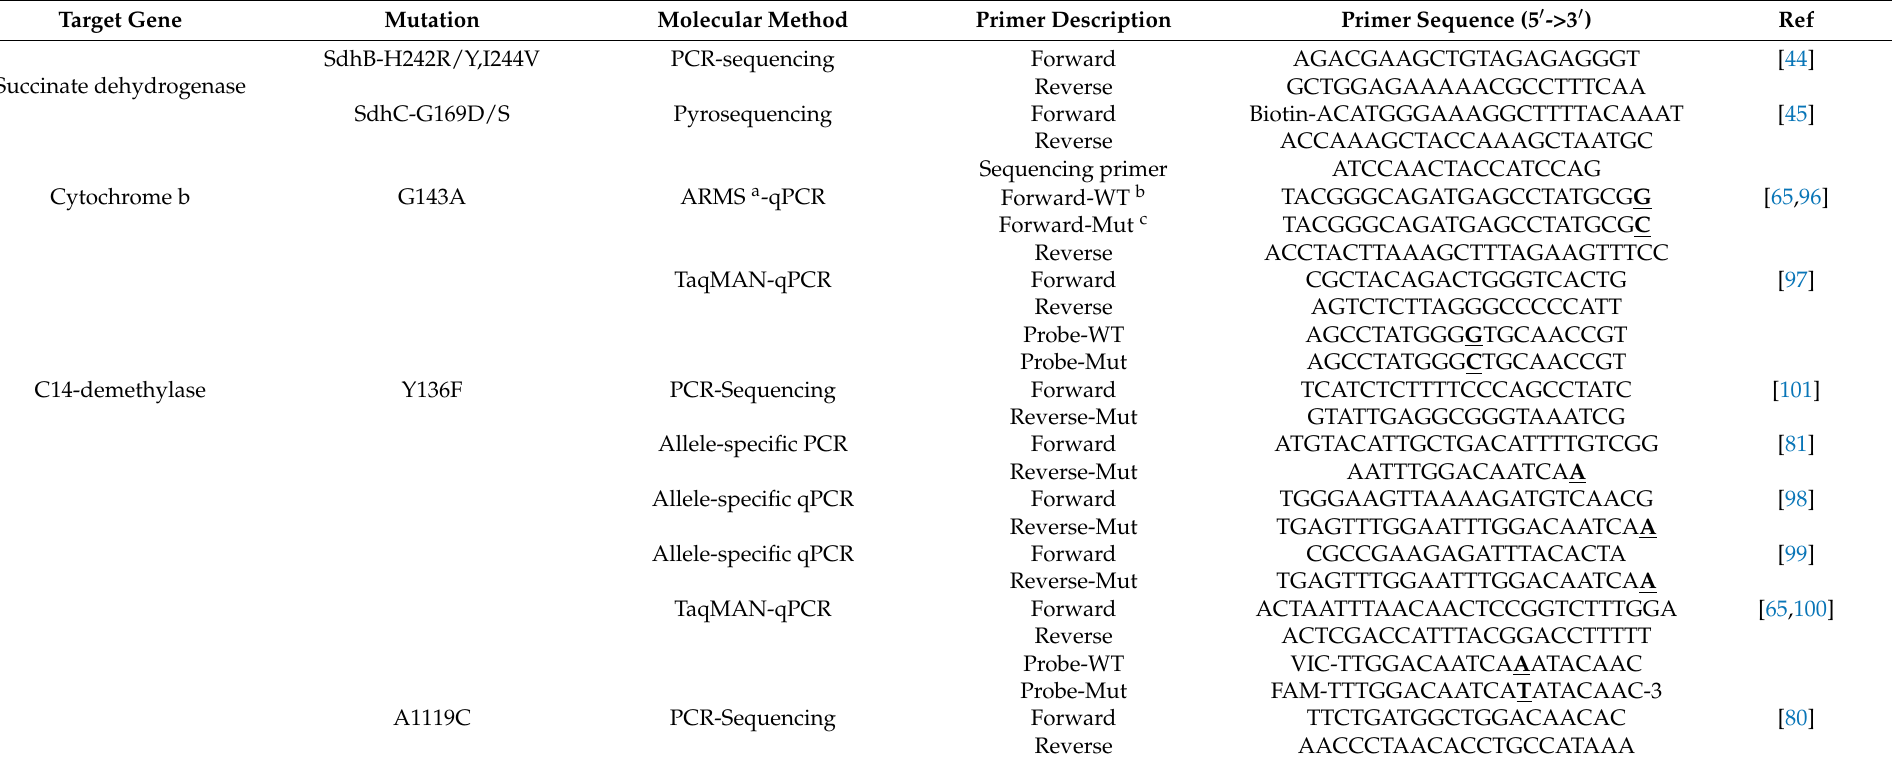
Table 3. Molecular methods developed for the detection of the SNP markers of the fungicide resistance in Erysiphe necator